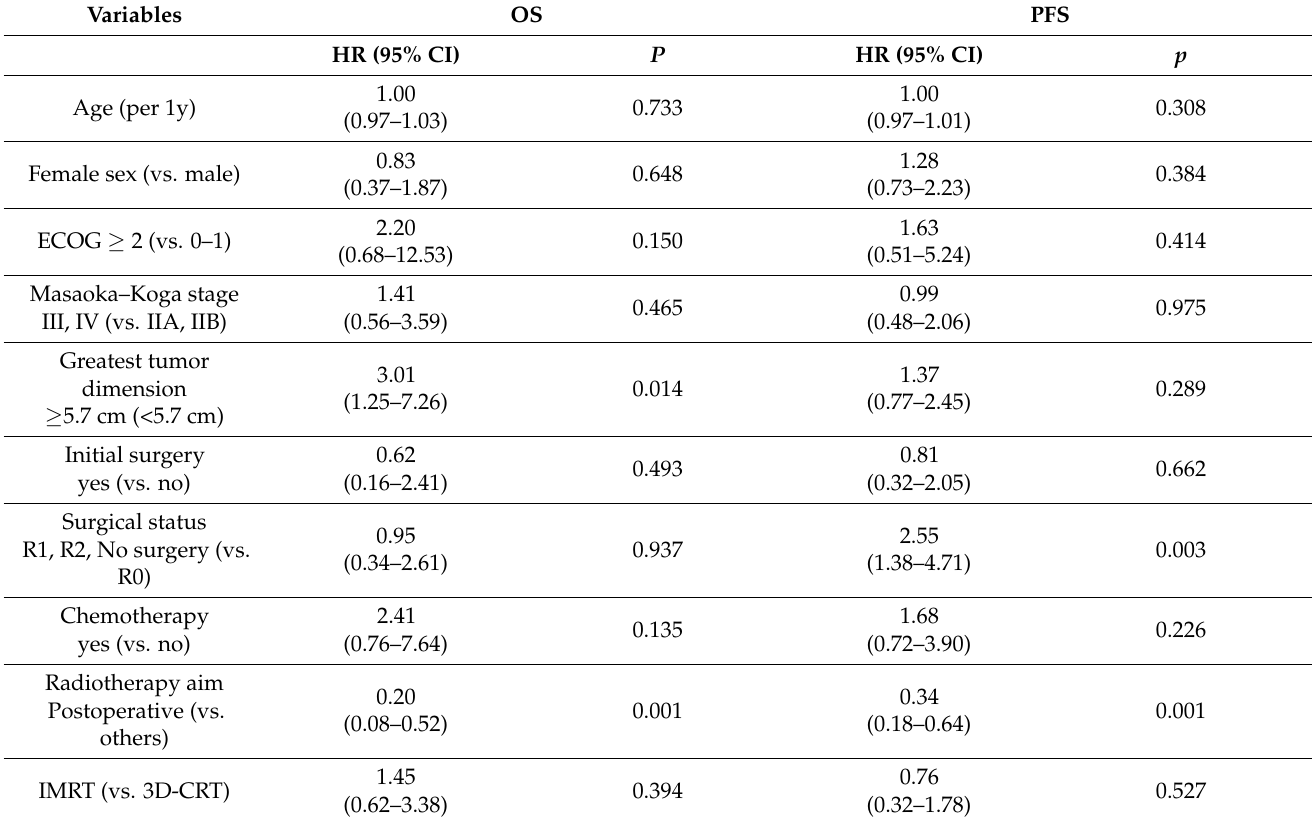
Table 4. Multivariate analysis for overall survival and progression-free